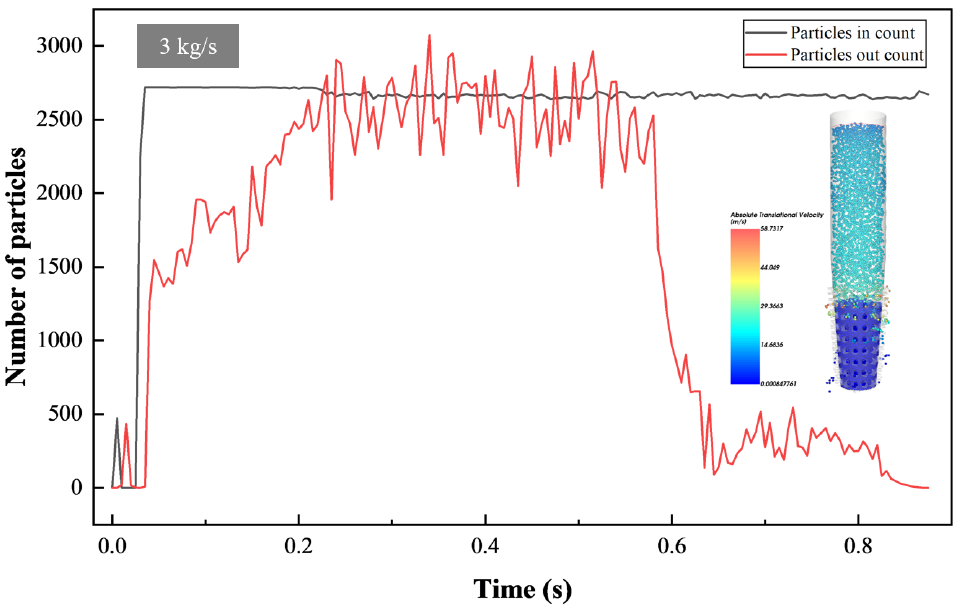
Figure 16. 1.6 mm LCMs entering at 3 kg/s mass flow.